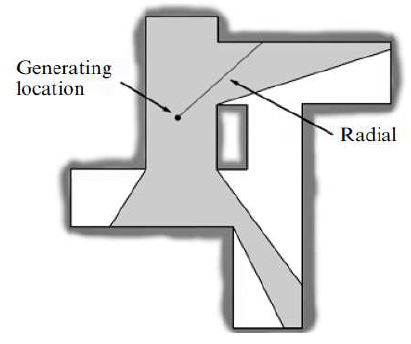
Figure 3. RGB-D structure (Chiabrando et al., 2017).